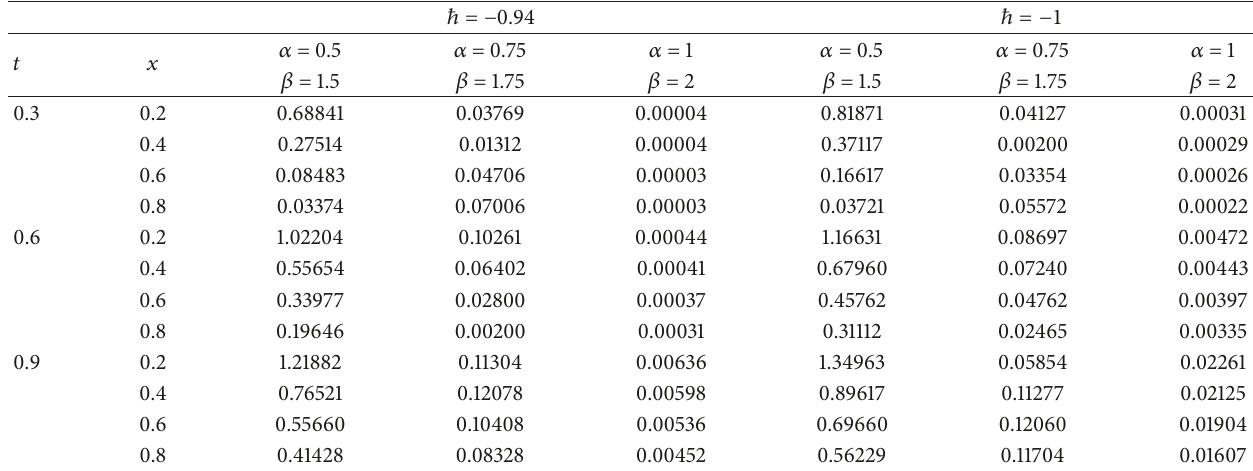
Table 1: The absolute errors for case A in Example 1.